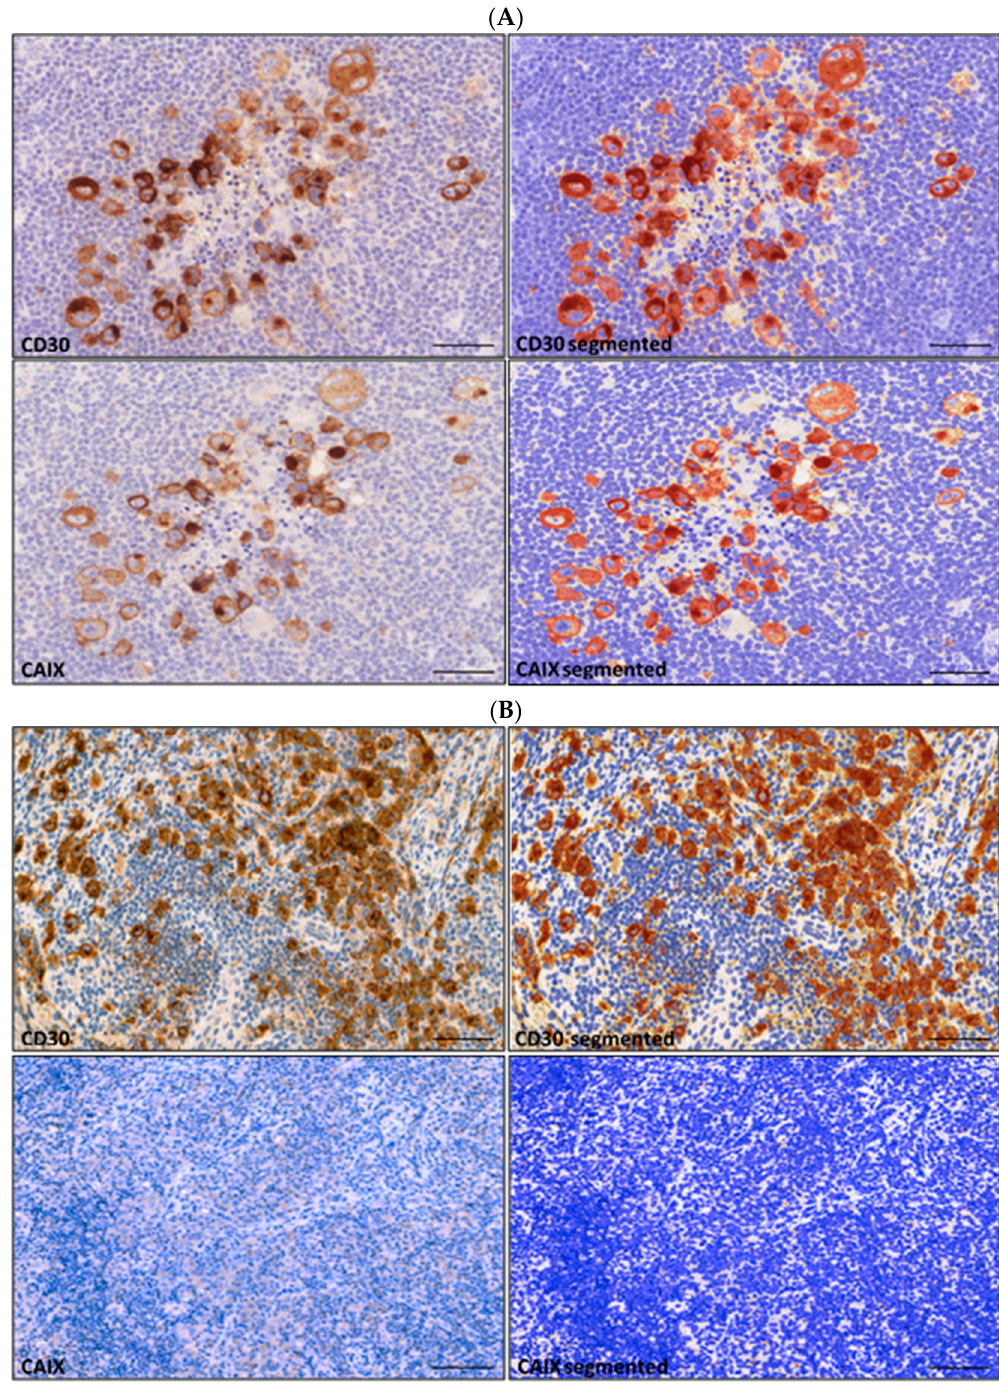
Figure 2. DensitoQuant digital image analysis of CD30 and CAIX-immunolabeling in CAIX positive ( A ) and negative ( B ) classical Hodgkin’s lymphoma. Immunopositivity of large atypical HRS cells (left) is highlighted as pseudocolored pixels (yellow / orange / red) following digital segmentation (right). Number and intensity of positive pixels were expressed as individual H-score for each sample. Scale bar = 100 μ m.